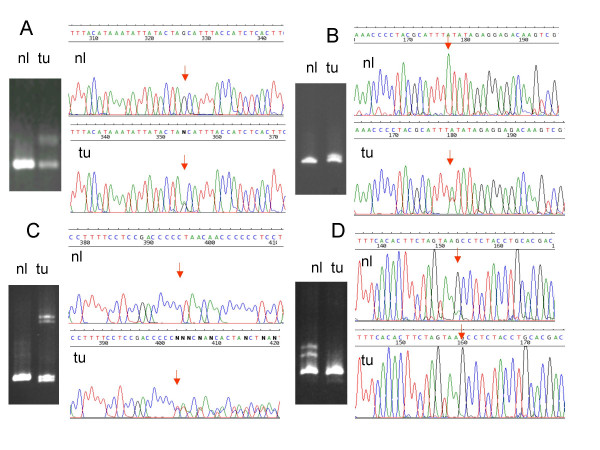
Novel somatic mtDNA mutations in esophageal cancer detected by TTGE and sequencing. A: Homoplasmic to heteroplasmic G10500A (A11T in ND4L) mutation in case E12 B: Heteroplasmic change of A1544T in 12S rRNA in case E05 C: Heteroplasmic deletion of 11bp (del TAACAACCCCC)at np10941 (110 × in ND4) in case E18 D: Heteroplasmic to homoplasmic change of A9182G (N219S) in ATPase 6 in case E15. The multiple banding pattern of TTGE in tumor confirms heteroplasmic change. tu: tumor, nl: normal